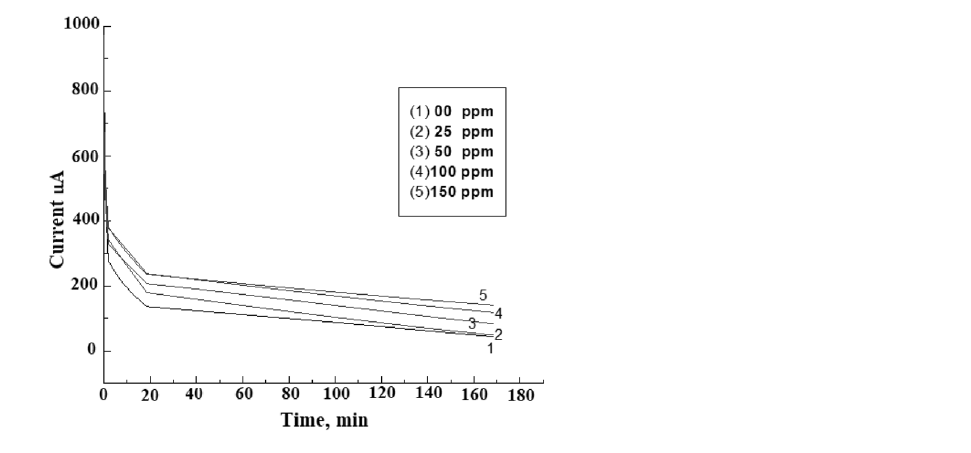
Figure 11. Chronoamperometry curves for polarized steel electrode in CaCl 2 brine solution in the absence and presence of different concentrations of studied polymer at –1 V vs SCE and 40